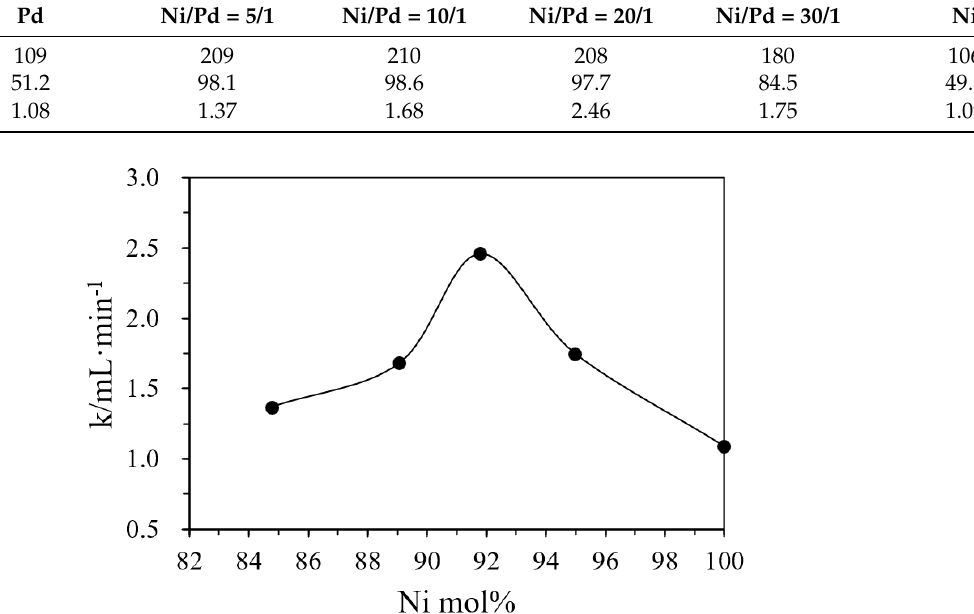
Table 2. Hydrogen production yields and rates (k) by hydrogel catalysts with various ratios of Ni/Pd at 50 °C. Figure 3. The positive synergy effect in the bimetallic catalysts with varying Ni molar percentages in the total metal amount in the hydrogel determined by ICP-AES on the initial hydrogen production rates. Note that pure Pd nanoparticles in the hydrogel have an initial rate (k) of 1.08 mL/min